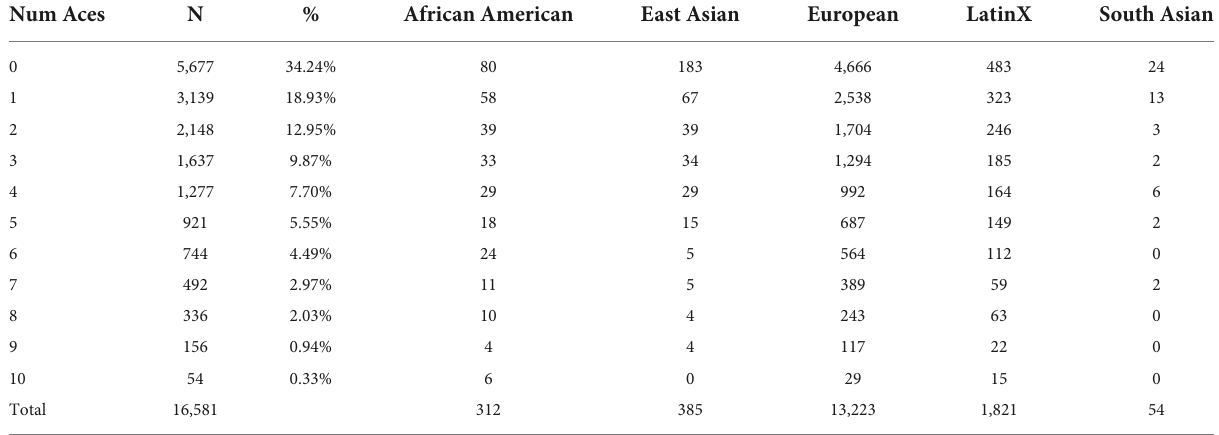
TABLE 1 Distribution of ACEs in the HNP ACE .